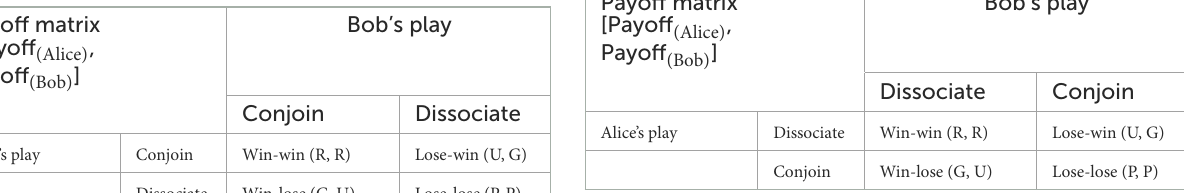
TABLE 2 The payoff matrix of Alice and Bob’s relationship in favor of union.